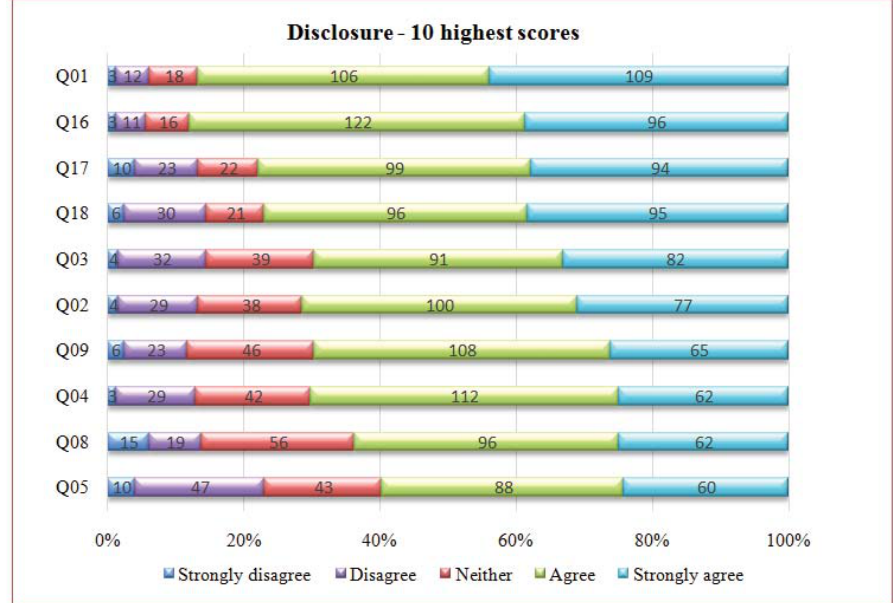
Fig. 3. Ten highest scores for